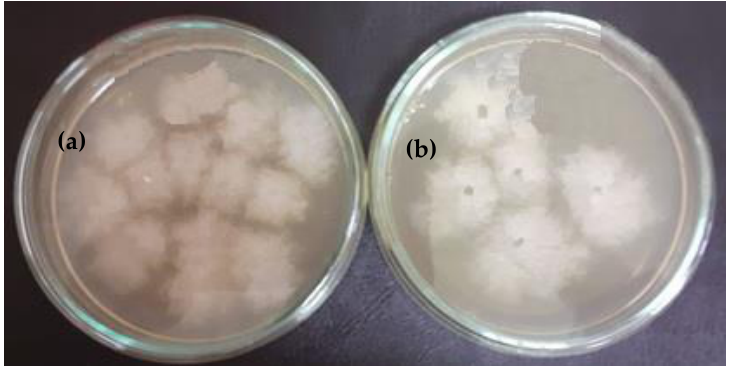
Figure 13. Number of UFC/mL resulting from submerged culture of Streptococcus pyogenes (control ( a ) and sample ( b )).